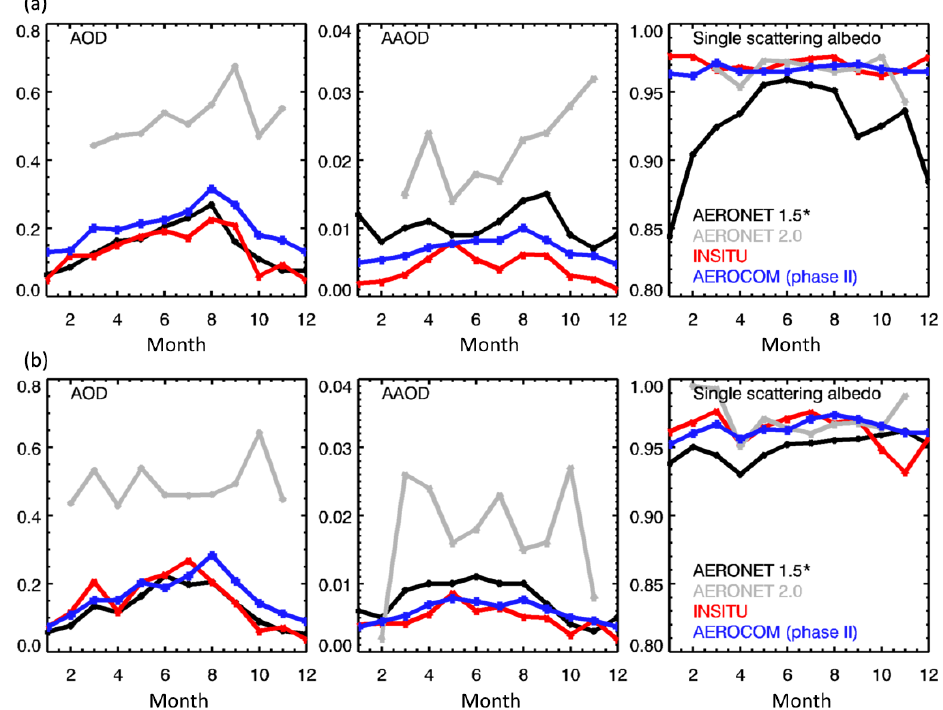
Figure 8. (a) Monthly medians of BND aerosol optical properties at 440nm. AERONET medians are for 1996–2011. AERONET AOD medians are for observations with Level 2 almucantar retrievals, with corresponding AAOD and SSA retrievals at Level 1.5 (black) or Level 2 (gray). In situ data are for June 2006–September 2009. AERONET Level 2.0 almucantar AOD and AAOD values are biased high by definition because of the AOD 440 >0.4 constraint. AERONET 2.0 direct-sun retrievals (not shown) are similar to the AERONET 1.5 AOD values. In situ values are derived from 365 flights over BND. AeroCom Phase II median model results cover various time periods (depending on the model) and are reported at 550nm. (b) Monthly medians of SGP aerosol optical properties at 440nm. AERONET medians are for 1996–2011. In situ data are for September 2005–December 2007. AERONET AOD medians are for observations with Level 2 almucantar retrievals, with corresponding AAOD and SSA retrievals at Level 1.5 (black) or Level 2 (gray). AERONET Level 2.0 almucantar AOD and AAOD values are biased high by definition because of the AOD 440 >0.4 constraint. AERONET 2.0 direct-sun retrievals (not shown) are similar to the AERONET 1.5 AOD values. In situ values are derived from 322 flights over SGP. AeroCom Phase II median model results cover various time periods (depending on the model) and are reported at